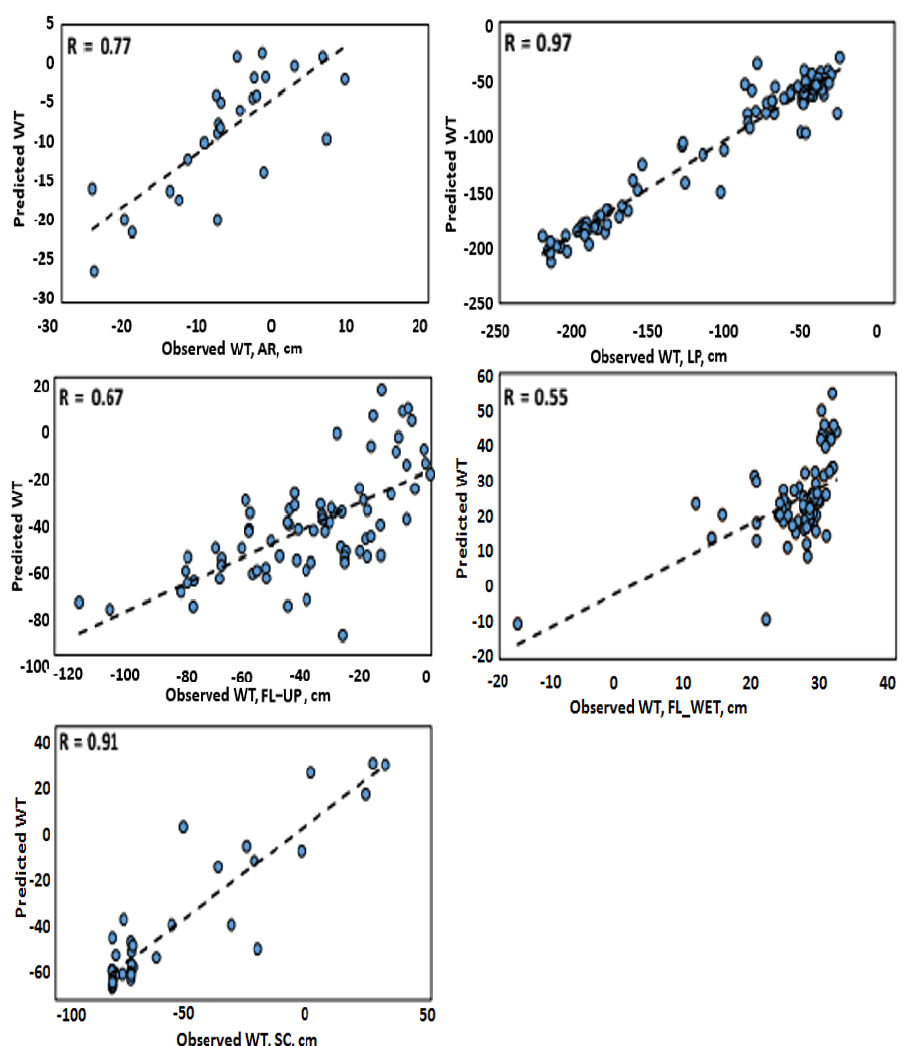
Figure 3. Scatter plots of the observed and predicted mean water tables in five wetlands in the SE United States (unit: cm), where dashed lines are the trend line, and R is the correlation coefficient between observed and predicted